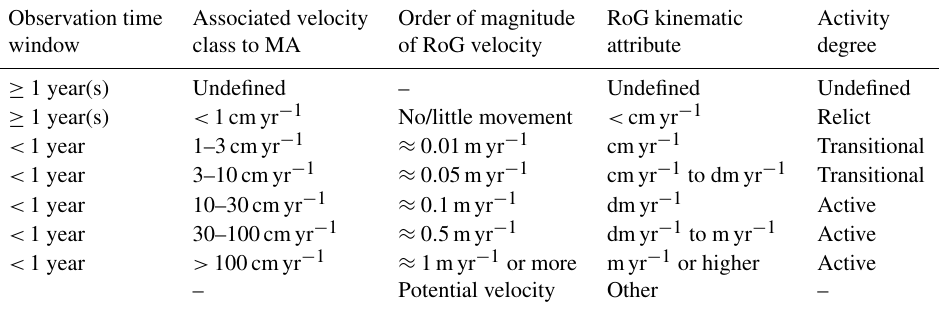
– Potential velocity Other